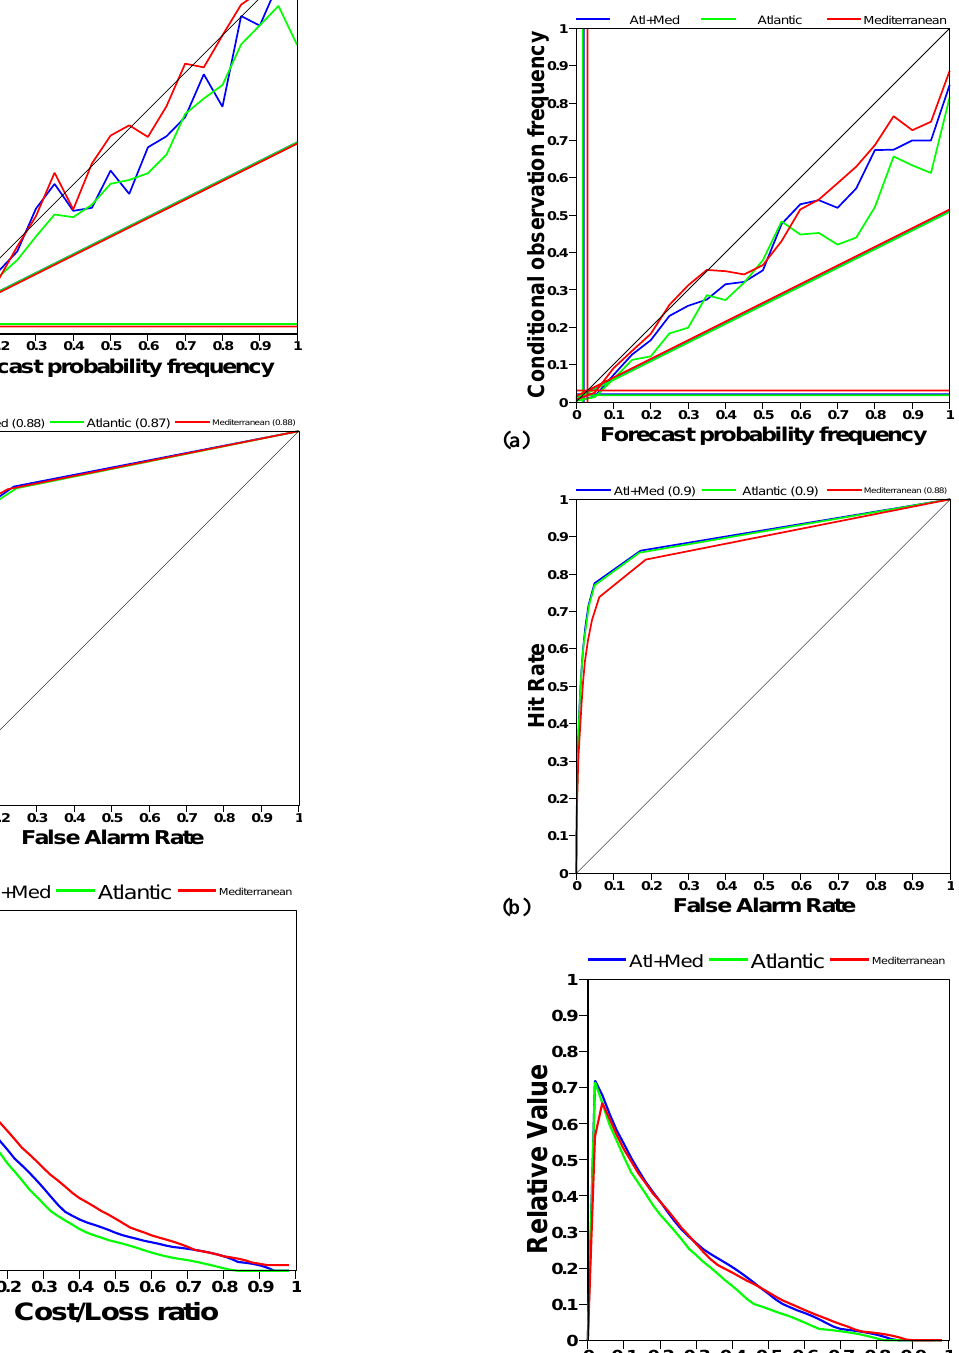
Fig. 3. (a) Attributes diagram, (b) Relative-operating- characteristics (ROC) curve and (c) Relative Value(RV) diagram to respectively assess reliability, discrimination and value with respect to sample climatology for the 24-h precipitation over 20mm proba- bility forecast in 2007 boreal summer (June-July-August (JJA)) over Mediterranean area (red lines), Atlantic area (green lines) and Total Europe area (blue lines).